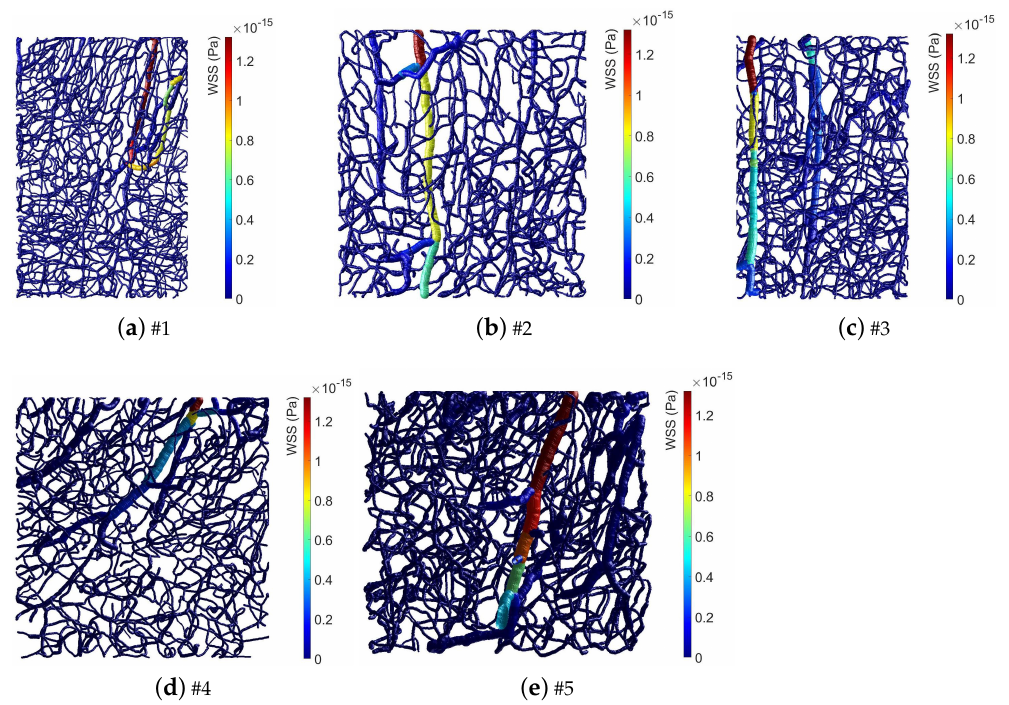
Figure 9. Computed endothelial shear stress of the 5 cerebrovascular regions of the murine cortex. The heat map represents by colors the average value of the shear stress per segment within the microcirculatory synthetic